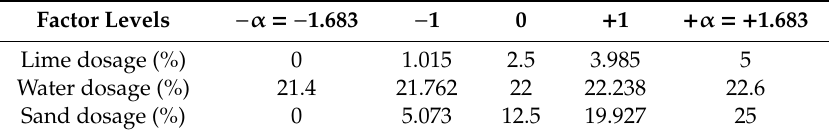
Table 1. Factor Levels of the Centered Composite